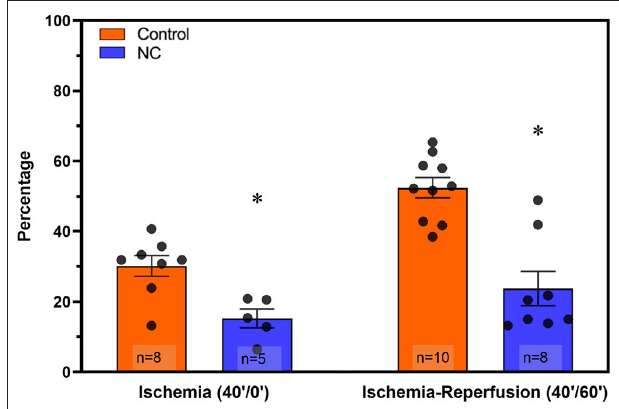
FIGURE 5 | NC attenuated both ischemic myocardial injury and post-ischemic reperfusion injury. Hearts were harvested from normothermic control and NC-treated mice at the end of 40min of ischemia (40 ′ /0 ′ , left) and at the end of 40min of ischemia followed by 60min of reperfusion (40 ′ /60 ′ , right) to evaluate infarct size by TTC-blue staining (calculated as a percentage area of the left ventricle region at risk). NC, topical neck cooling; * p < 0.05 vs. corresponding